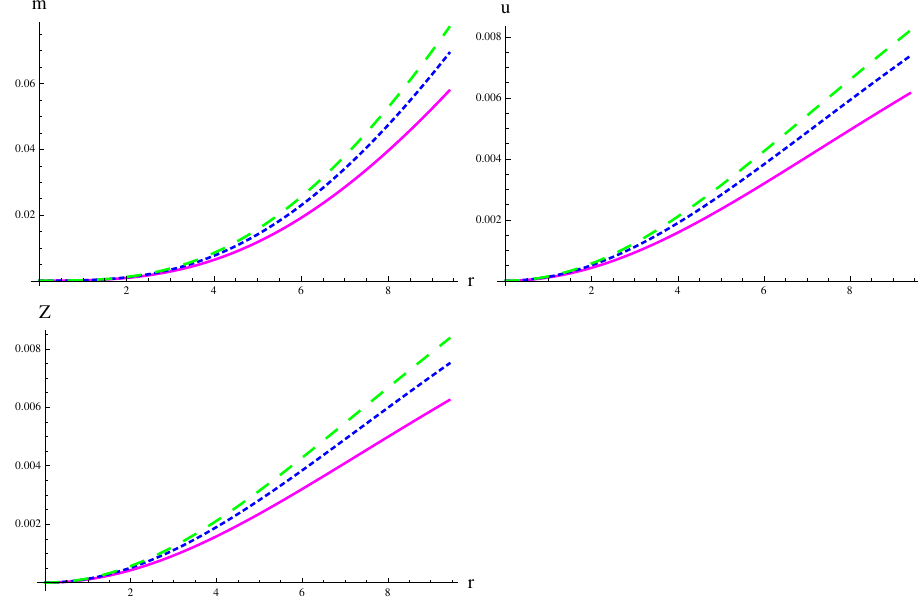
Figure 7. Behavior of m , u and Z corresponding to solution I for Υ =